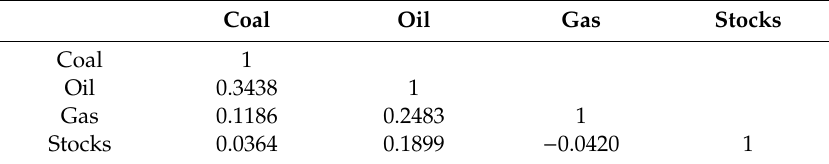
Table 5. Correlations for USA.